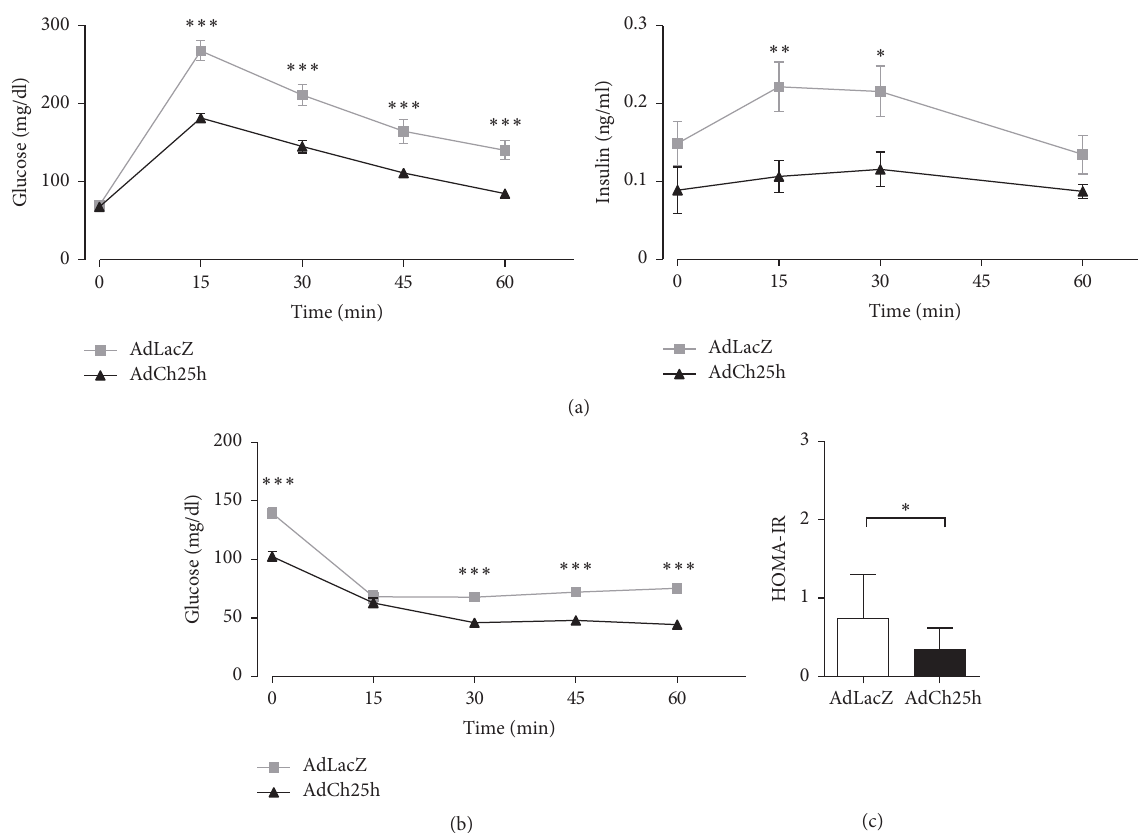
Figure5:OverexpressionofhepaticCh25himprovedglucosetolerance,insulinsensitivity,andloweredHOMA-IR.(a)Oralglucosetolerance tests (OGTT) performed in AdLacZ and AdCh25h transduced C57BL/6J animals. The glucose (mg/dl) and insulin (ng/ml) levels were measured 15, 30, 45, and 60 min after administering glucose solution (1g/kg). Blood glucose and insulin levels were significantly lower in the AdCh25h transduced subpopulation. Two-sided 𝑝 values obtained from unpaired 𝑡 -test. Results are mean ± SEM. ∗ 𝑝 < 0.05 , ∗∗ 𝑝 < 0.01 , and ∗∗∗ 𝑝 < 0.001 . 𝑛 = 5 per group. (b) Insulin tolerance tests (ITTs) on AdCh25h and AdLacZ transduced C57BL/6J mice. Regular human insulin was administered intraperitoneally and blood glucose levels were monitored and measured 15, 30, 45, and 60 min after injections. The blood glucose levels were clearly decreased in mice treated with AdCh25h. Two-sided 𝑝 values obtained from unpaired 𝑡 -test. Results are mean ± SEM. ∗∗∗ 𝑝 < 0.001 , 𝑛 = 5 per group. (c) HOMA-IR levels of AdLacZ and AdCh25h transduced C57BL/6J mice. Comparison of the control group to the AdCh25h treated mice showed a significant decrease in HOMA-IR levels. Results are mean ± SEM. ∗ 𝑝 < 0.05 , 𝑛 = 5 per